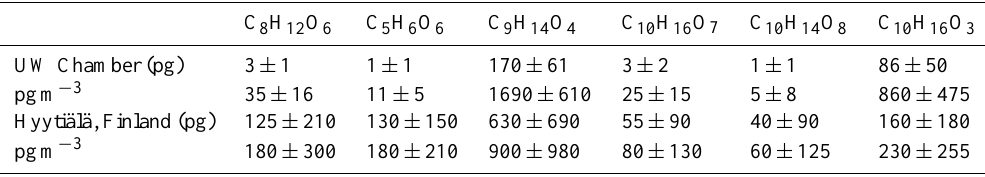
Table 1. Detection limits for two different sampling conditions: first, from the UW-Chamber (see text for operation details), second, for a 2-week ambient data set from Hyytiälä, Finland. All species reported were detected at the deprotonated ion. Detection limits represent 3 σ confidence levels, where ion signals were converted to mass using the instrument’s formic acid sensitivity. All detection limits are calculated for each blank pair and the average is reported here, with ± 1 standard deviation. For the chamber conditions there is little temporal change, but high gas phase concentrations. In Hyytiälä, gas phase concentrations are significantly lower; however, temperatures are much colder and there is more temporal atmospheric change, resulting in higher detection limits on average. For Hyytiälä, there is also an increase in the variability of the blank, represented by the standard deviation, relative to the steady-state chamber because atmospheric variability drives relatively larger changes in the field blanks. Because of frequent determinations, we are able to capture much of that variability on the timescales of hours and are therefore able to remove the changing artifact from the data. Detection limits are also reported in pgm − 3 by taking into account the volume of air sampled across the filter during particle collection which was different between the chamber and the field